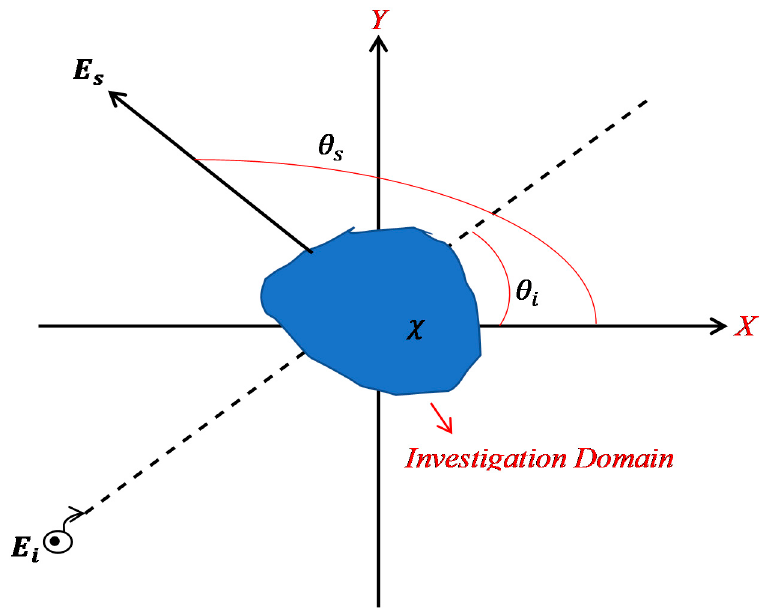
Figure 1. The general geometry of the inverse scattering problem .